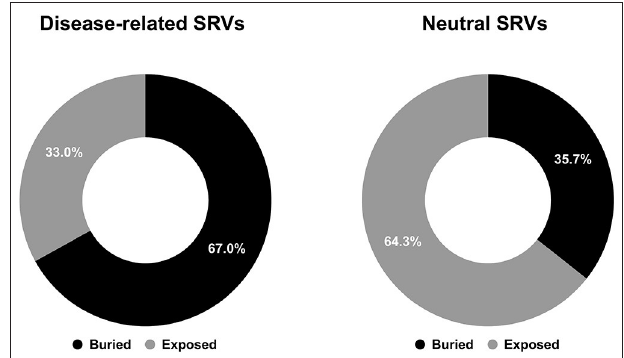
FIGURE 1 | Pie charts showing the fractions of buried/exposed wild-type residues undergoing disease-related (left) and neutral (right) SRVs in the HVAR3D-2.0 dataset, respectively.